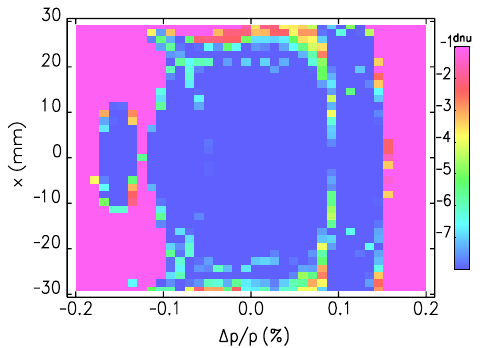
FIG. 12. Frequency map in the ( x (cid:1) (cid:1) p=p ) phase space for the 2nd-order DS scheme with the color indicating the tune diffusion d .